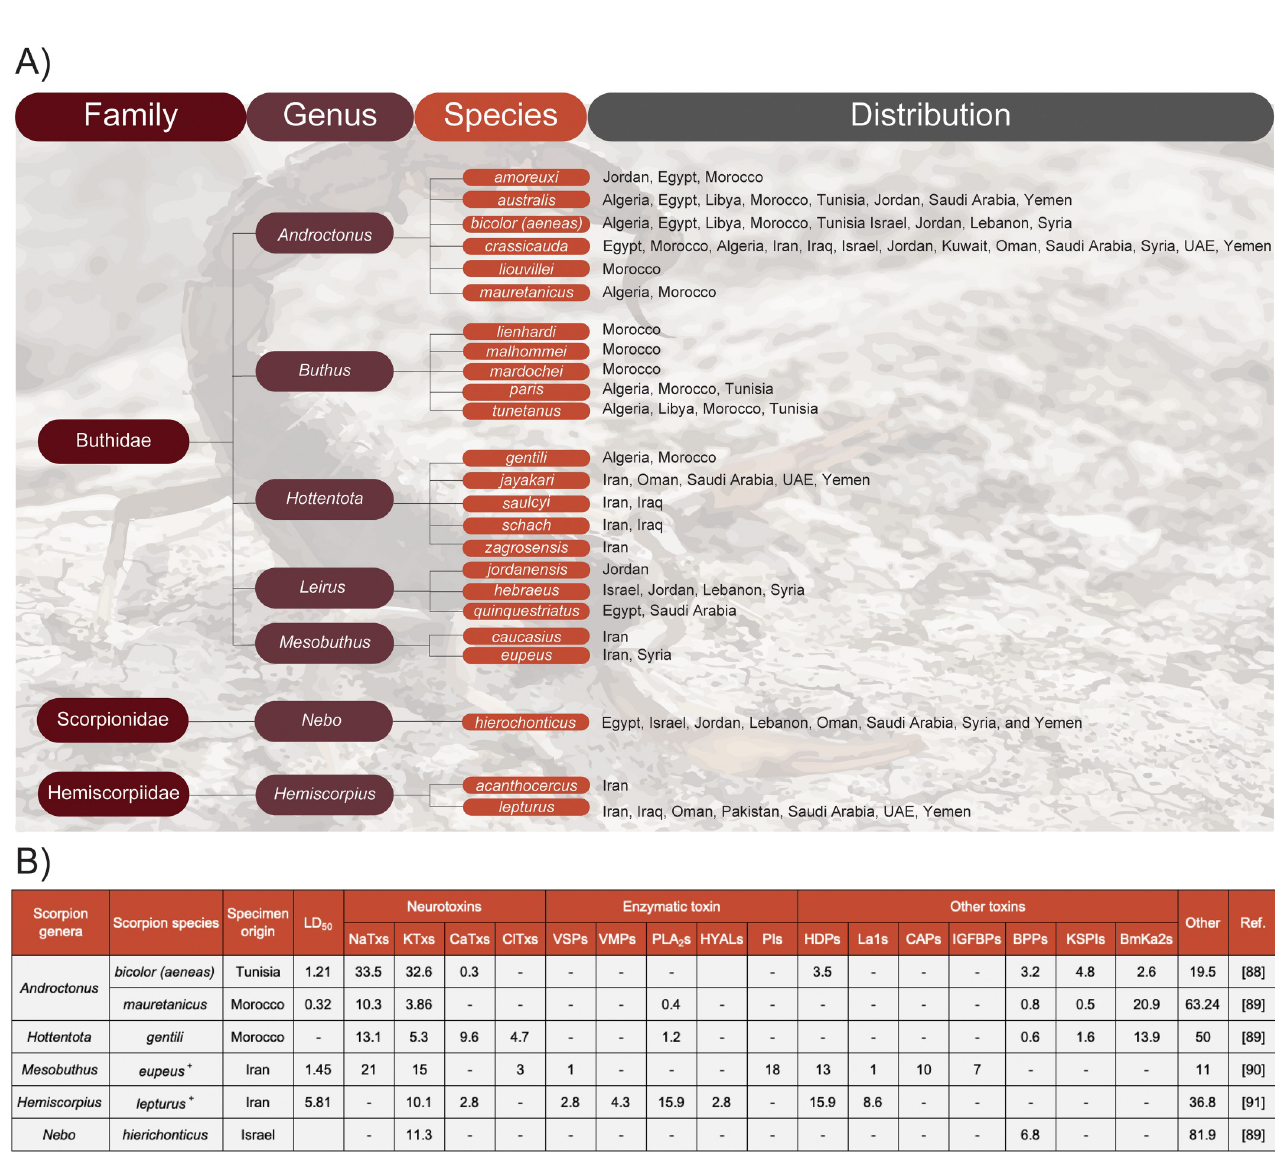
Fig 2. Medically important scorpions in North Africa and the Middle East. (A) Phylogeny and geographic distribution and (B) reported toxicity and available venom proteome or transcriptome ( + ) data are shown [88–91]. Specifically, the table presents the genera, species, the origin of the reference proteome or transcriptome, and the median lethal dose in mice (LD 50 ; mg/kg). It also illustrates the relative abundance of toxins acting on Na + channels (NaTx), toxins acting on K + channels (KTxs), toxins acting on Ca 2+ channels (CaTxs), toxins acting on Cl − channels (ClTxs), VSPs, VMPs, PLA 2 s, HYALs, PIs, HDPs, La1s, antigen-5 and CAPs, IGFBPs, BPPs, KSPIs, NDBPs (e.g., BmKa2s), and other (often a result of lacking data). All components are represented as relative wet weight abundance in %. Notably, scorpion venom composition may vary depending on region. BPP, bradykinin-potentiating peptide; CAP, pathogenesis- related protein; HDP, host defense peptide; HYAL, hyaluronidase; IGFBP, insulin-like growth factor binding protein; KSPI, kunitz-type serine protease inhibitor; La1, La1 peptide; NDBP, non-disulfide-bridged peptide; PI, protease inhibitor; PLA 2 , phospholipase A 2 ; VMP, venom metalloproteinase; VSP, venom serine